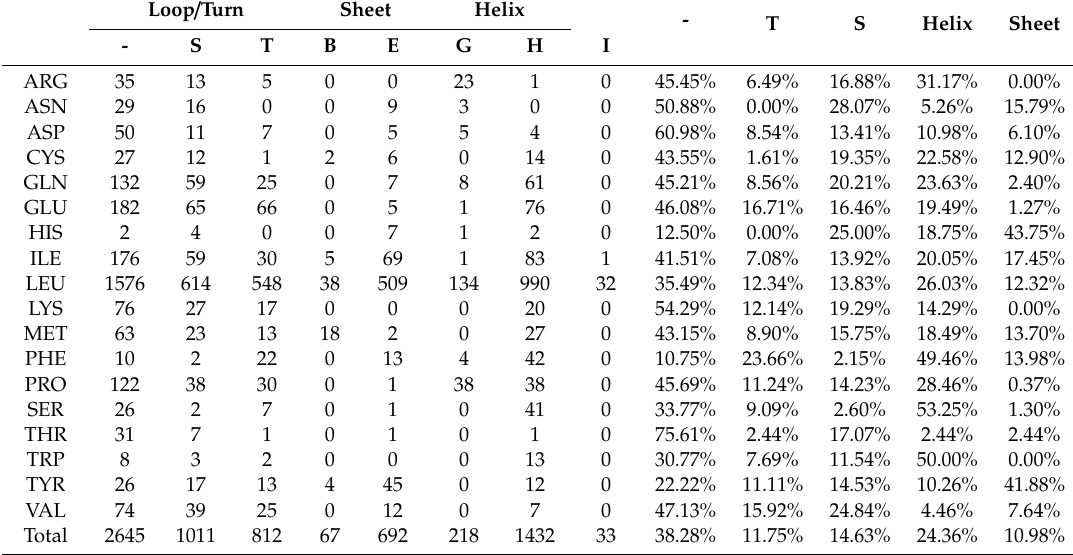
Table 2. The number of HBOS outliers and the percentage of the EM-0-4-2019 dataset in di ff erent secondary structure categories. “-“ (coil), “T” (hydrogen-bonded turn), “S” (bend between two secondary structures), “G” (3-turn helix), “H” (4-turn helix), “I” (5-turn helix), “E”(extended strand in sheets), and “B” (isolated beta-bridge in β